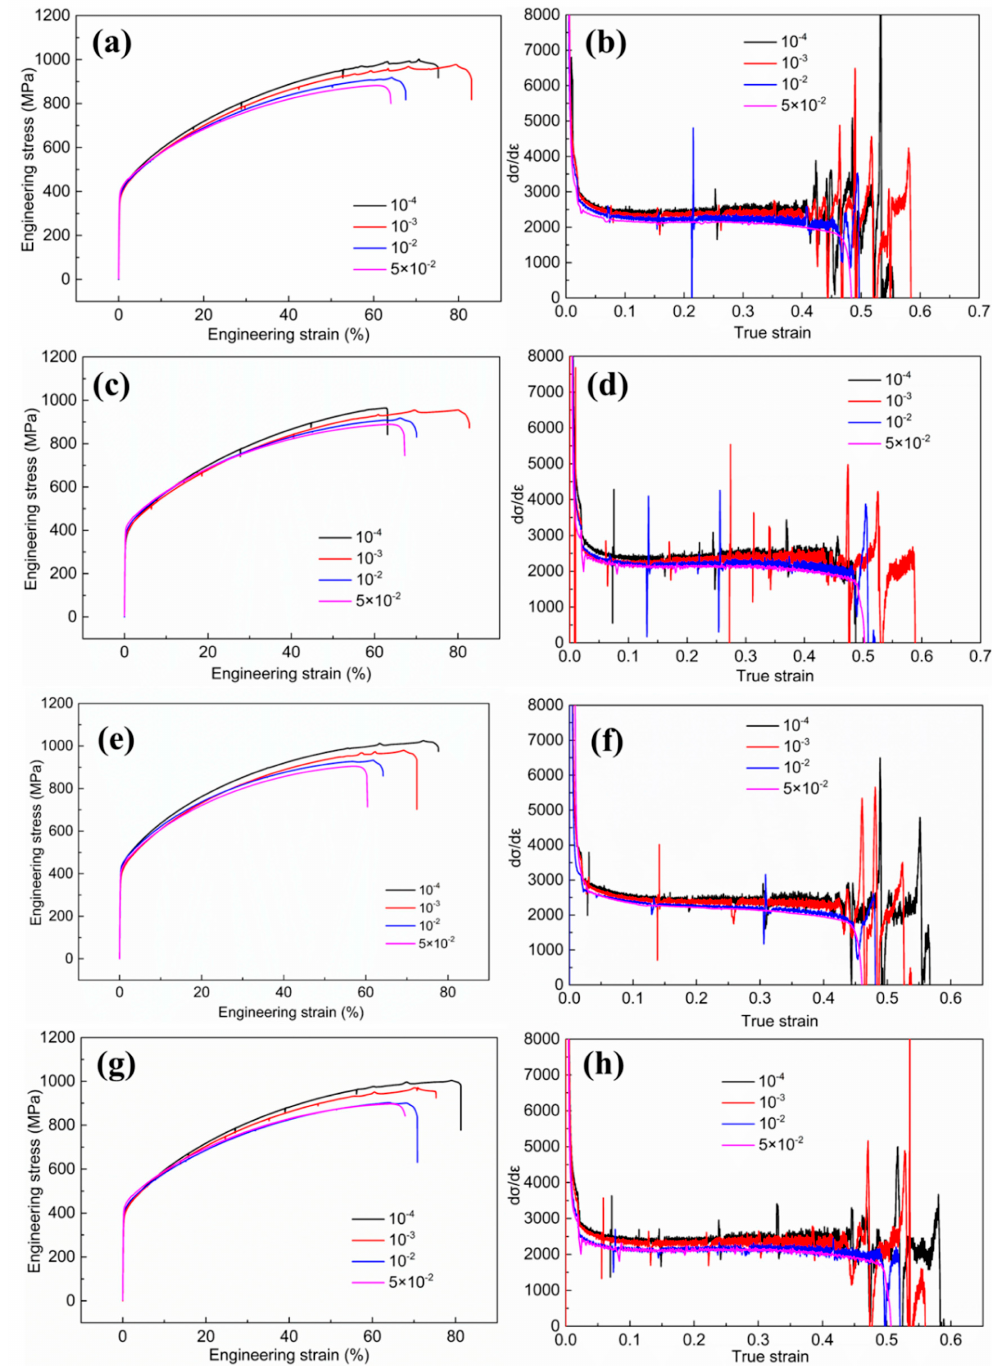
Figure 8. The engineering stress-engineering strain curves and corresponding work hardening rate-true curves of the tested material at different strain rates. ( a , b ) 1 h, ( c , d ) 2 h, ( e , f ) 5 h, ( g , h ) 10